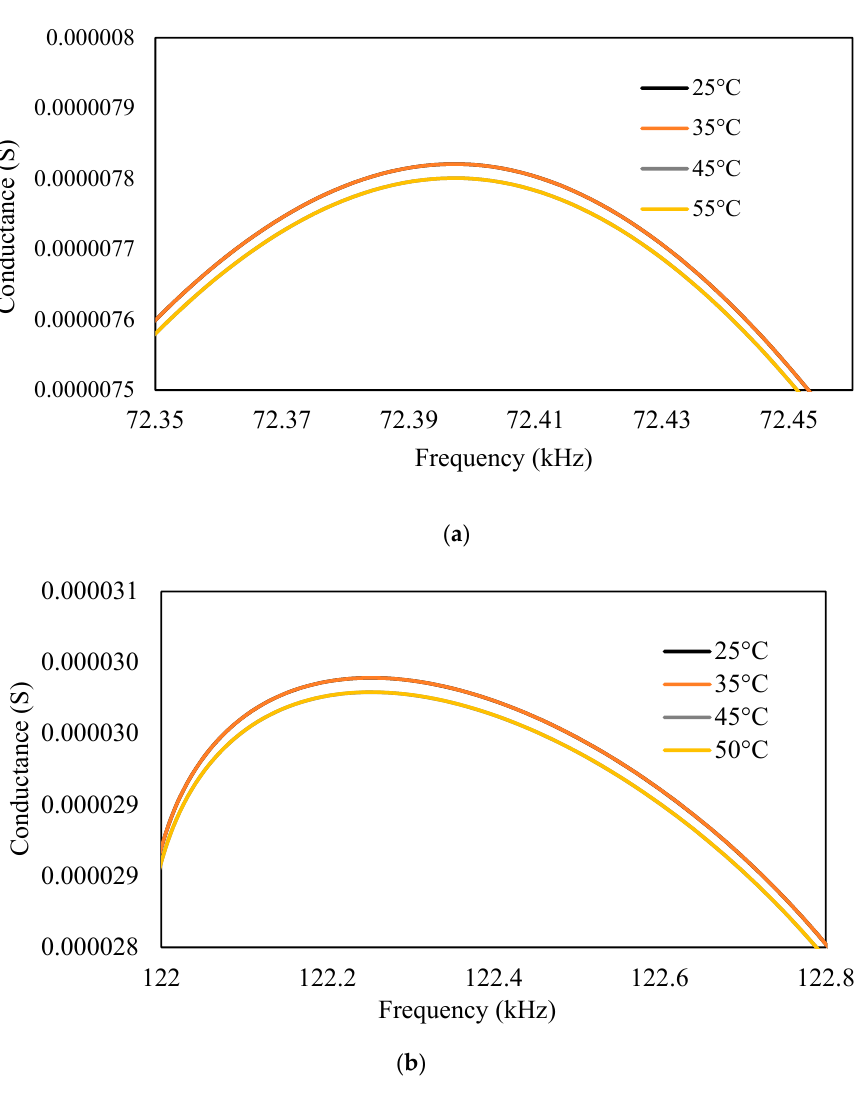
Figure 14. Conductance signature plot at different temperatures by varying ( a ) ε 33 ( b ) d 31 of PZT patch (of free PZT patch).